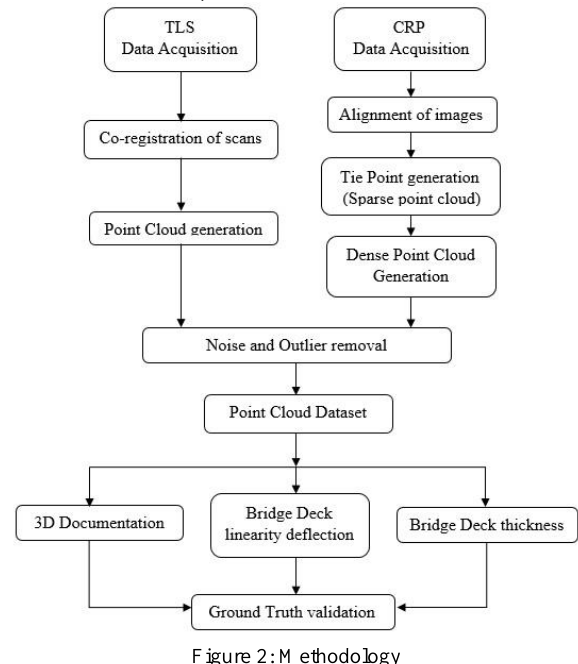
Figure 4: Top drawing of Truss Bridge